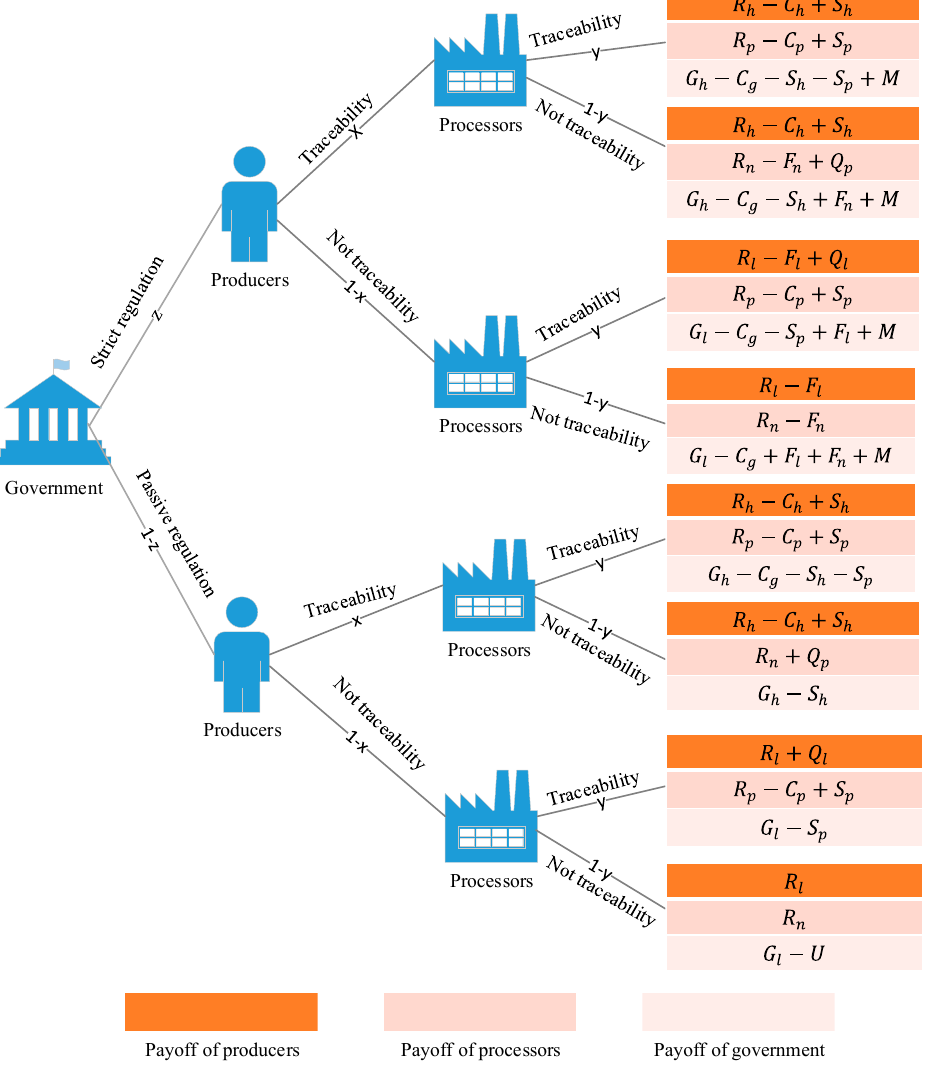
Figure 2. The game tree and payoffs of government, producers and processors According to Equations (1)–(3), the replicator dynamic for producers adopting trace- ability were determined as: